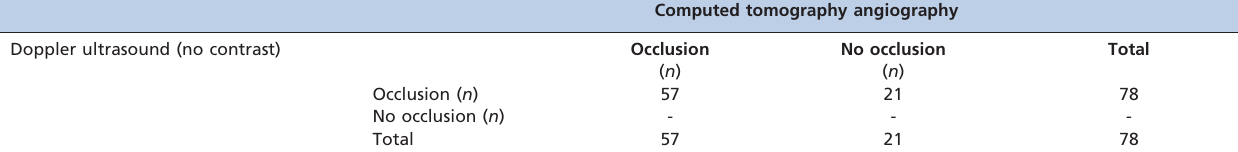
Table 1 - Distribution of the 78 internal carotid arteries classified as occluded by Doppler ultrasound (without contrast), according to the computed tomography angiography results.